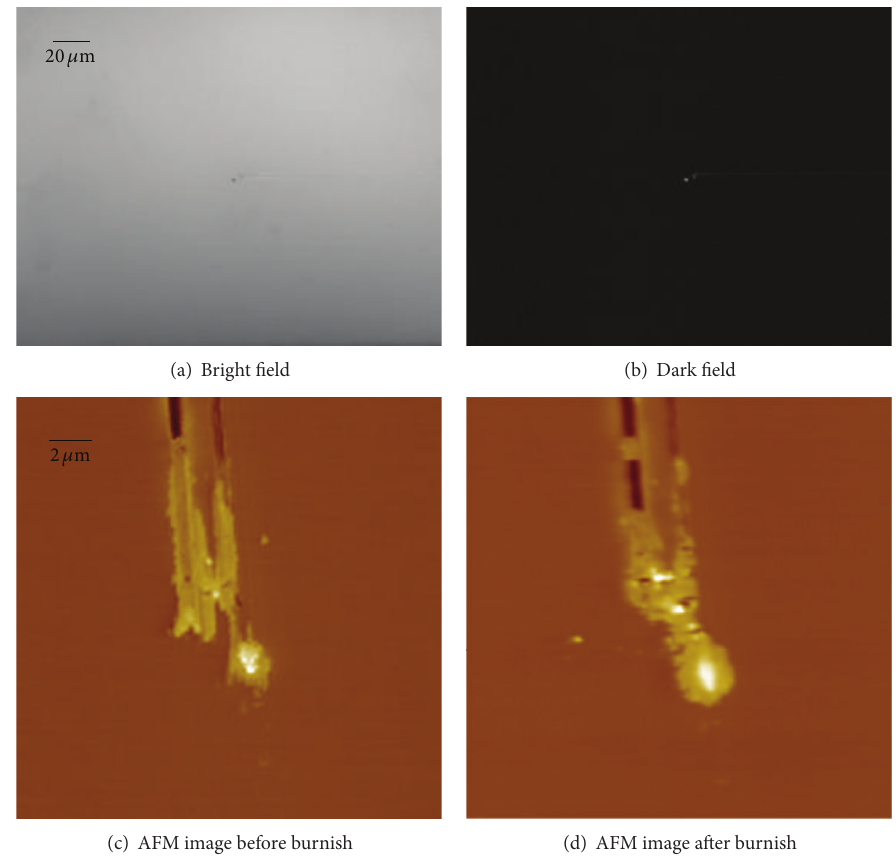
Figure 9: Correlated images of a media defect from a teardown disk sample. (a) Bright field image. The defect is very small but can be seen as speck of dark spot in the center of the image. (b) Dark field image. The defect is more visible and a scratch is also revealed against the dark background. (c) AFM images before the burnish sweeps. (d) AFM images after the burnish